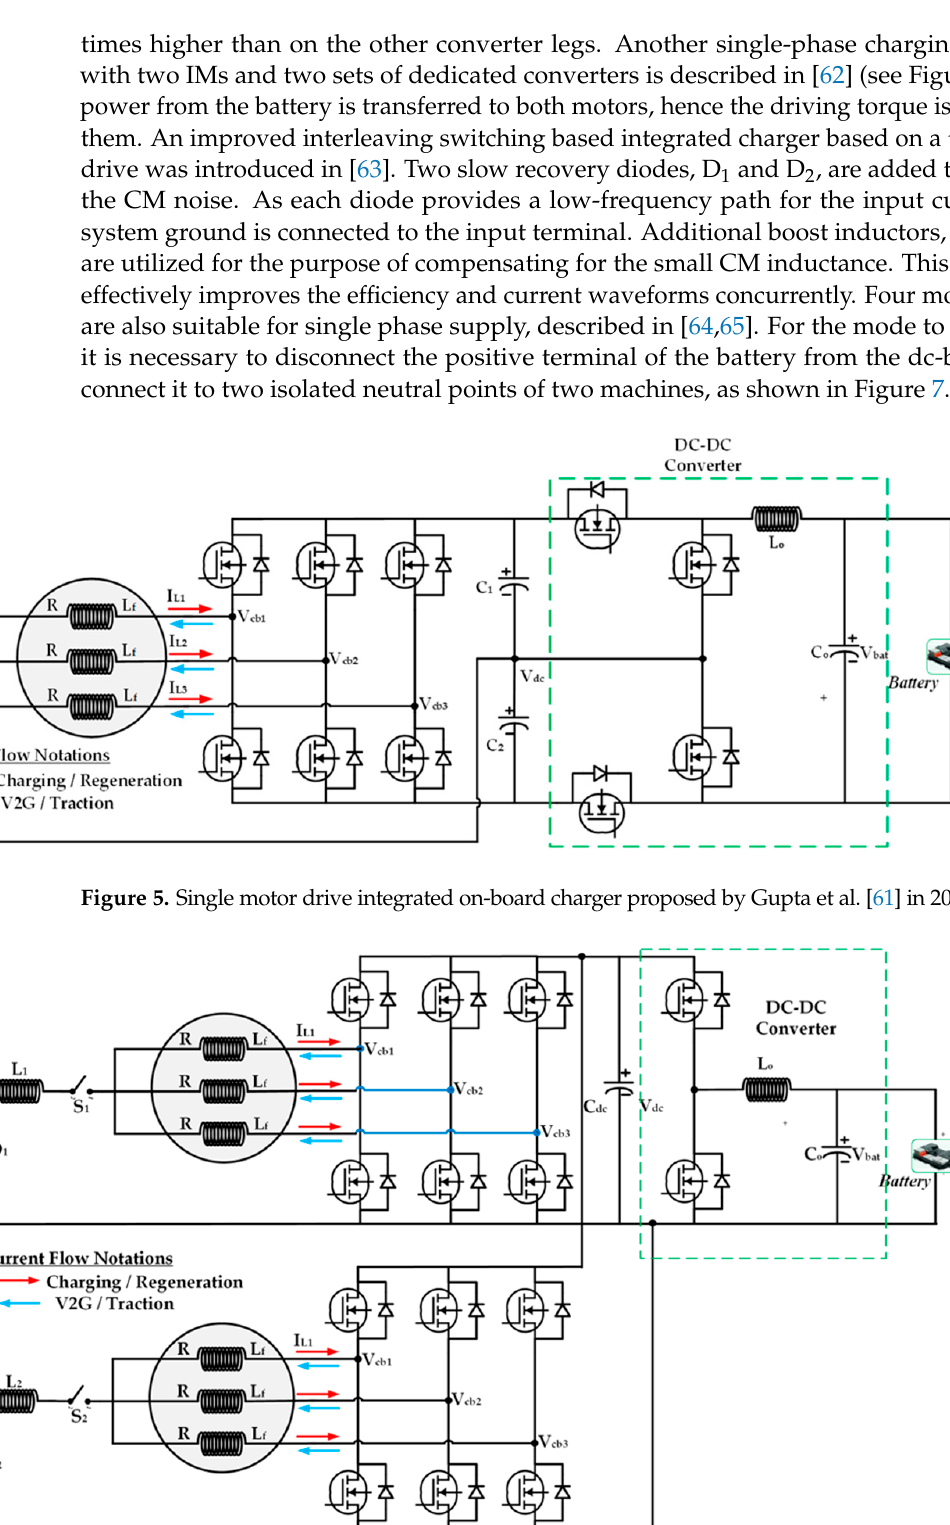
Figure 6. Dual motor drive integrated on-board charger proposed by Woo et al. [62] in 2015 (iOBC2).